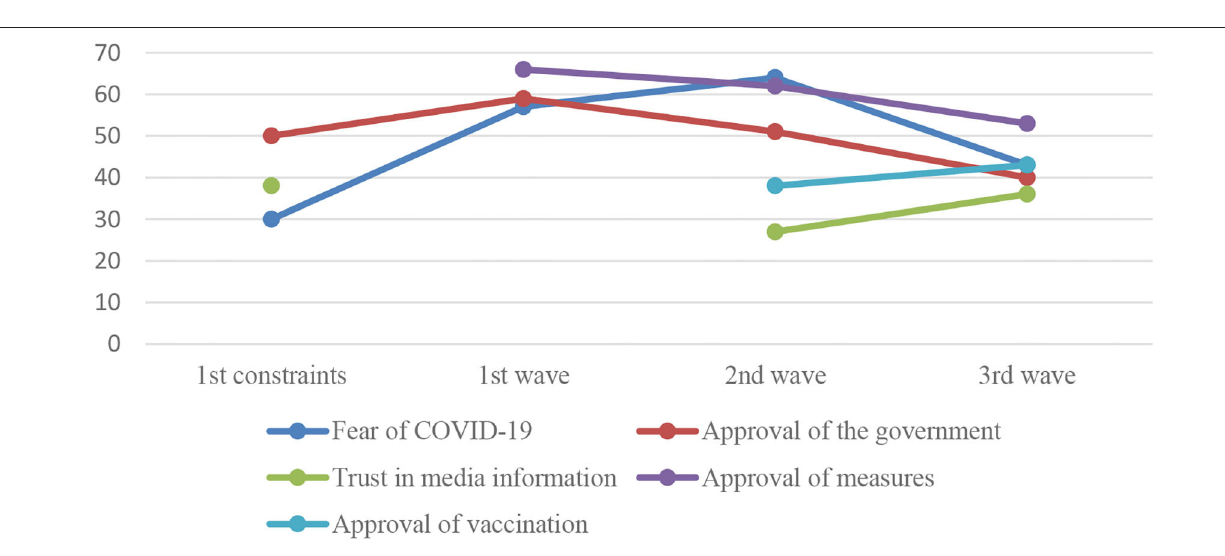
FIGURE 2 | Fluctuation of public perception over the study periods